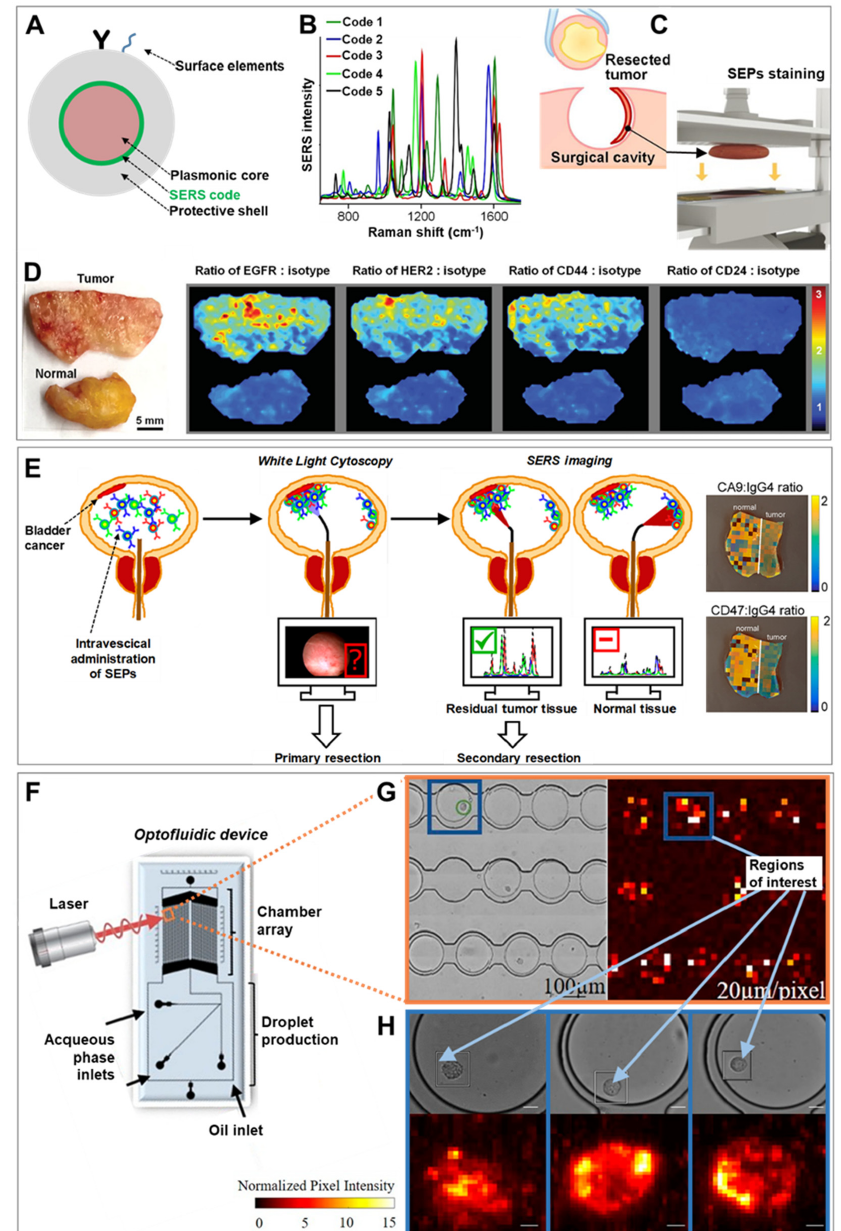
Figure 1. ( A ) Schematic depiction of the traditional surface-enhanced Raman scattering (SERS)-encoded nanoparticle (SEP) construction. ( B – D ) Application of SERS imaging to resected tumor tissue for intraoperative surgical guidance: ( B ) Unique SERS spectra of five different codes on gold particles coated with a silica shell. ( C ) Upon excision, the resected sample is placed in an automated staining device combining multiple quick dipping of the specimen into a SEPs solution with high-frequency vibration for fast and extensive topically applications of encoded particles onto the surface of the fresh tissue. ( D ) Ratiometric images biomarker targeting SEPs vs. negative control (isotype) obtained from raster-scanned SERS imaging (<3 min) of the illustrated human breast tumor and normal tissue. Adapted with permission from [18]. Copyright 2016, Wiley-VHC. ( E ) Schematic of the proposed application of intravesical SERS imaging for intraoperative endoscopic surgery. Adapted with permission from [19]. Copyright 2018, American Chemical Society. ( F – H ) SERS-microfluidic device for single live cell analysis: ( F ) Schematic depiction of the droplet-based optofluidic device; ( G ) Low-resolution map of the chamber array, ( H ) High-resolution map of individual cells encapsulated in droplets. Adapted with permission from [20] Copyright 2018, American Chemical